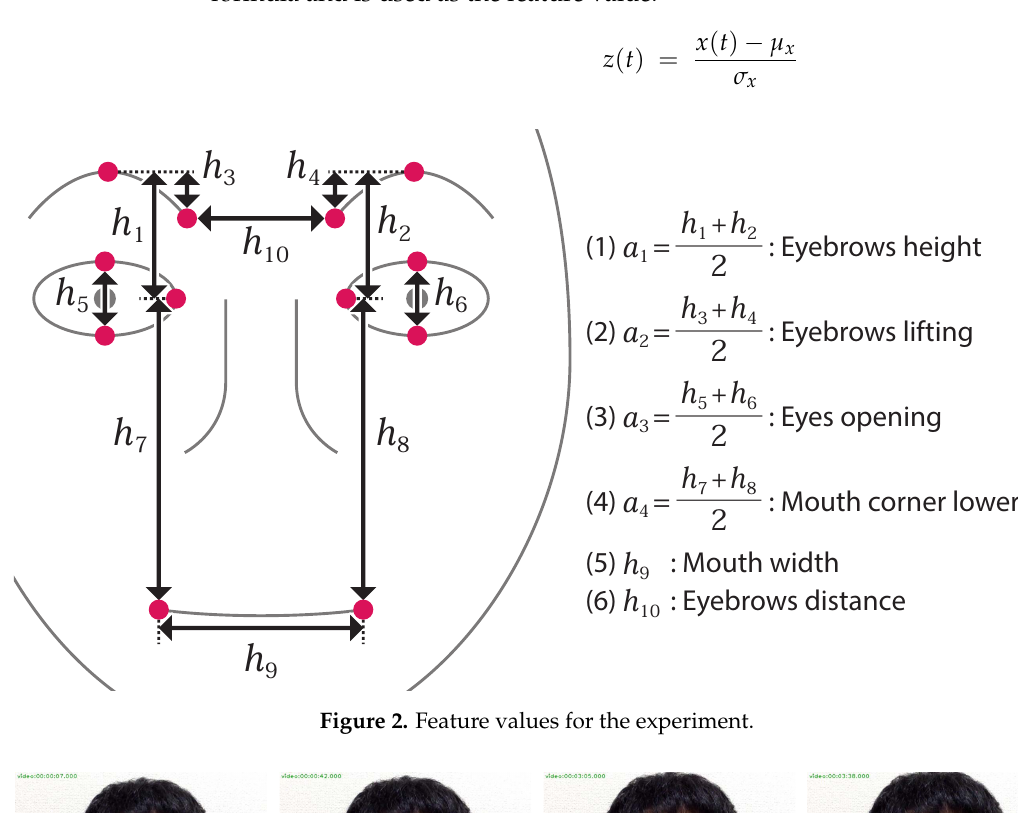
Figure 2. Feature values for the experiment.